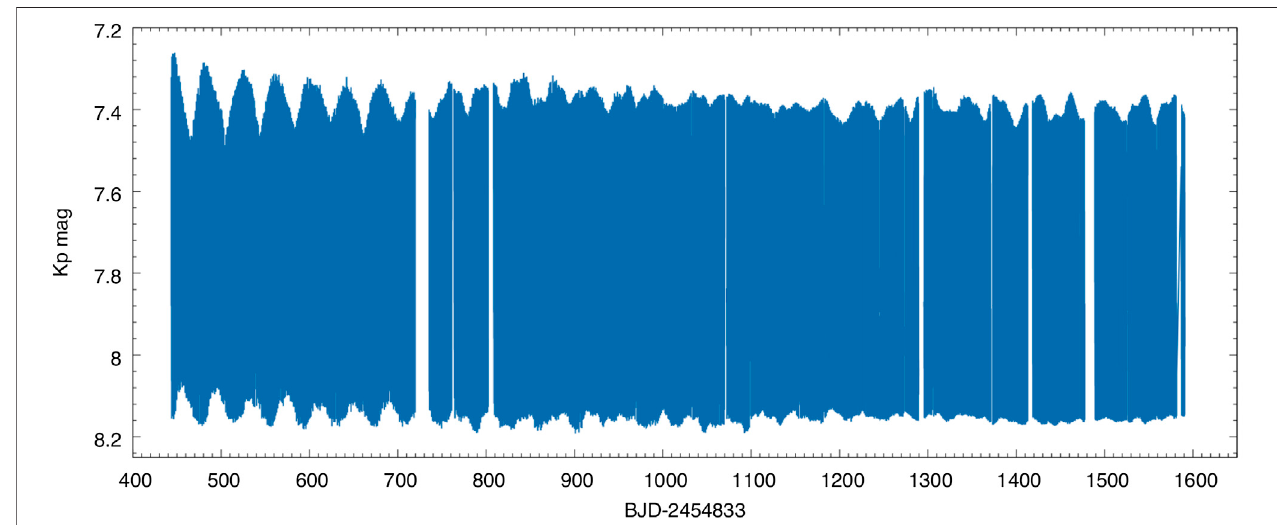
FIGURE4 | The Kepler Q5-Q17 short cadencedata lightcurveofRR Lyr, the eponymof its class. Datadownloaded from the MAST. Note that individual pulsation cycles are not discernible on this scale. Gaps are present in the data due to safe mode events and other occasional technical